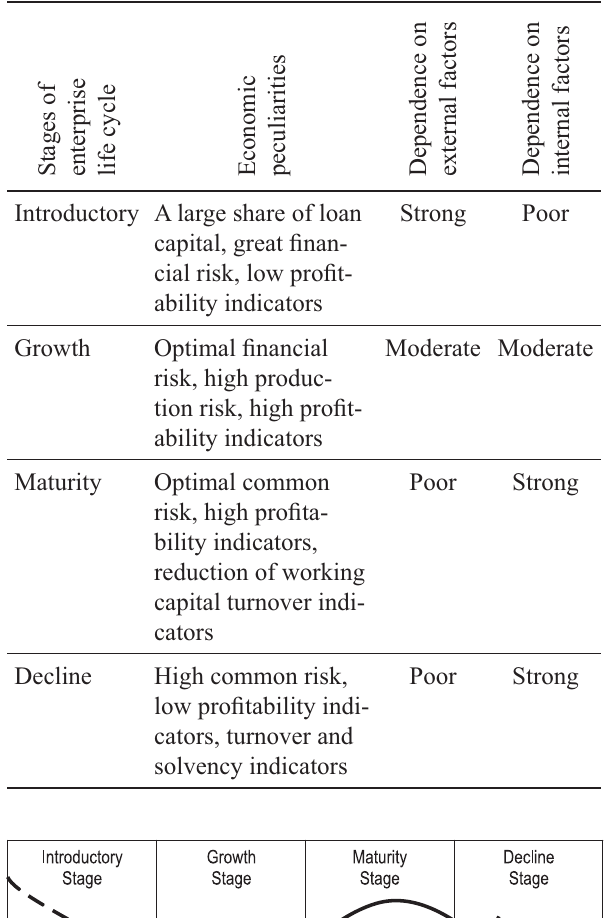
Table 3. Organizational and economic peculiarities of the